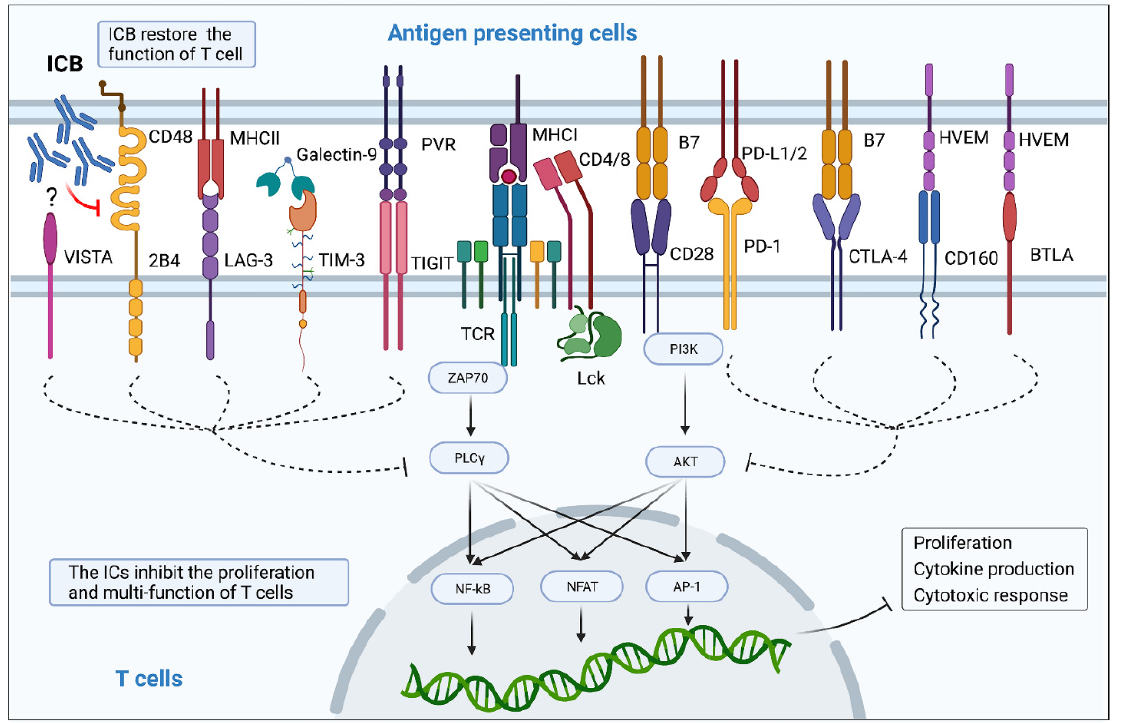
Figure 1. Immune checkpoint proteins impair proliferation and multi-functionality of T cells. Inter- action between immune checkpoint markers and their ligands transmits inhibitory signals to CD4 + and CD8 + T cells. These inhibitory signals limit TCR- and CD28-mediated co-stimulatory pathway, including the NF- κ B, NFAT, and AP-1 signaling pathways, which suppress proliferation, cytokine production, and cytotoxic response. IC blockers are able to cause ligand dissociation from the ICs and restore T cell activation.